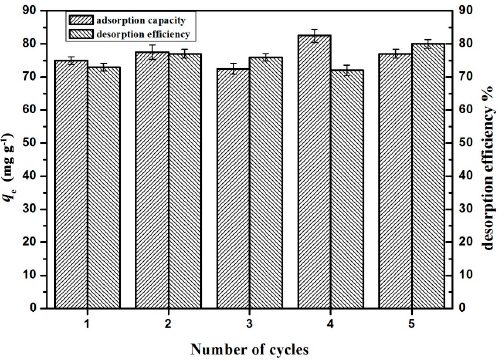
Figure 11. Effect of recycling bioadsorbents on Cu 2+ adsorption (initial concentration 200 mg·L − 1 ; initial pH of solution 5.3, temperature, 298 K; contact time, 120 min). The error bars represent standard deviations based on three measurements.